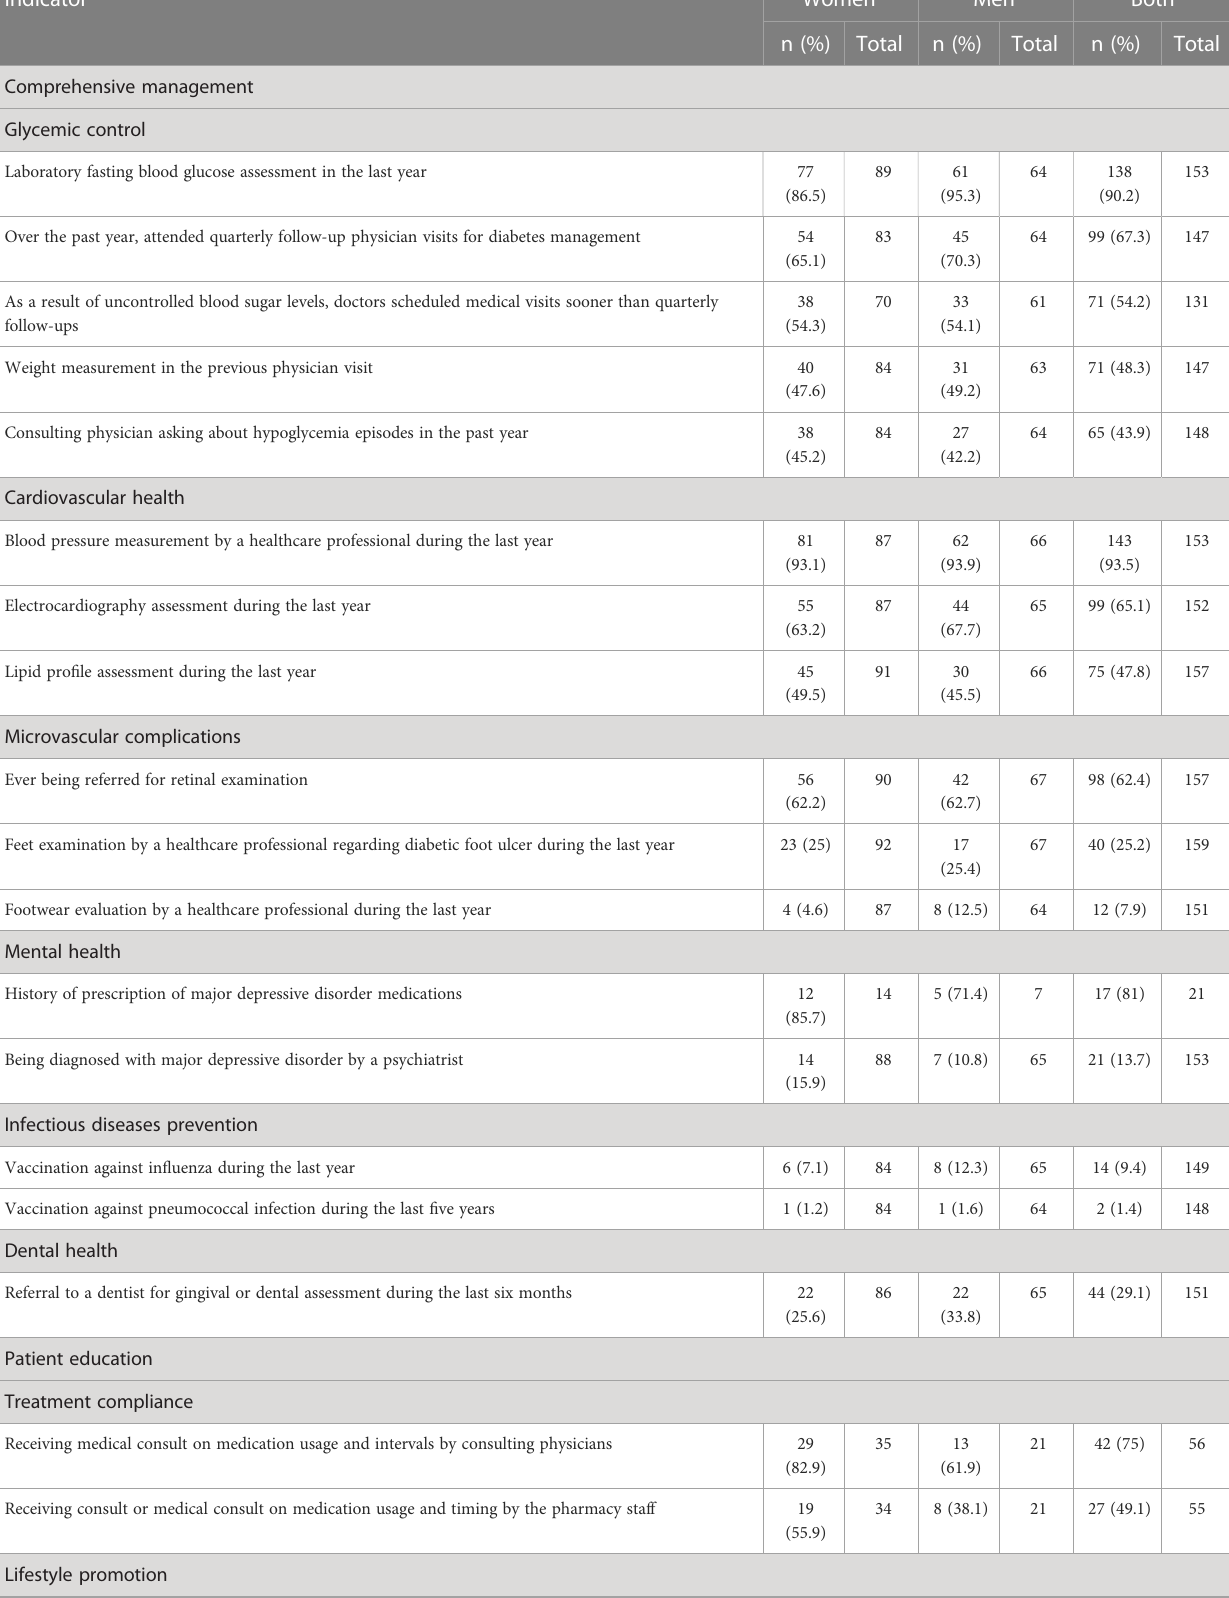
TABLE 3 Diabetes healthcare quality